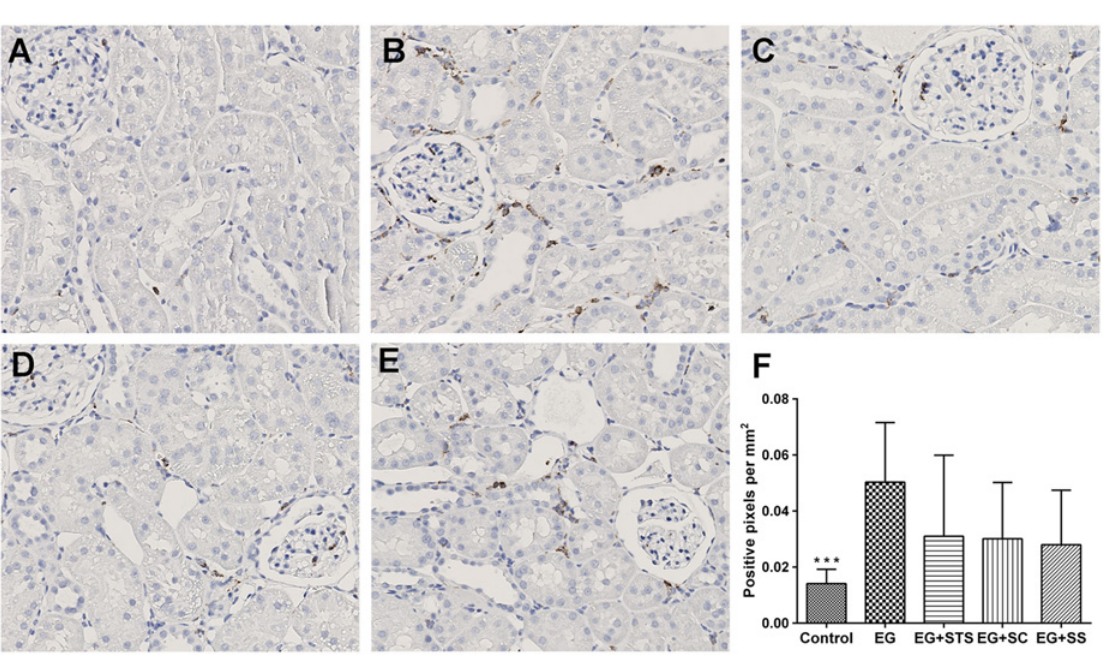
Fig 4. ED-1 stain of kidney tissue. The groups are (A) control, (B) EG-exposed, (C) EG+STS-exposed, (D) EG+SC-exposed, (E) EG+SS-exposed animal groups. The ED-1 stain was markedly increased in EG-exposed animals but decreased in all treatment groups. The significance levels are with reference to the EG group. The data are means ± SD from 7 – 8 animals per group. *** p < 0.001.